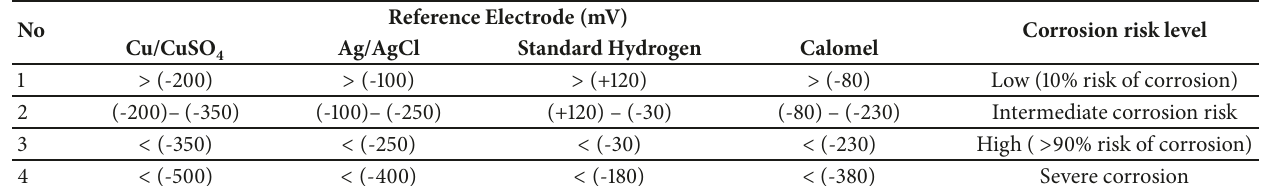
Table 1: Criteria for corrosion risk levels with referring to ASTM C876 [4].